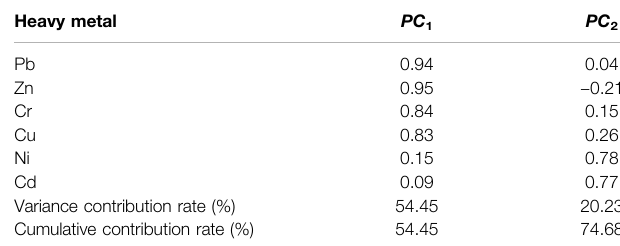
TABLE 5 | Principal component load analysis of heavy metals in the surface sediments of the Minghu